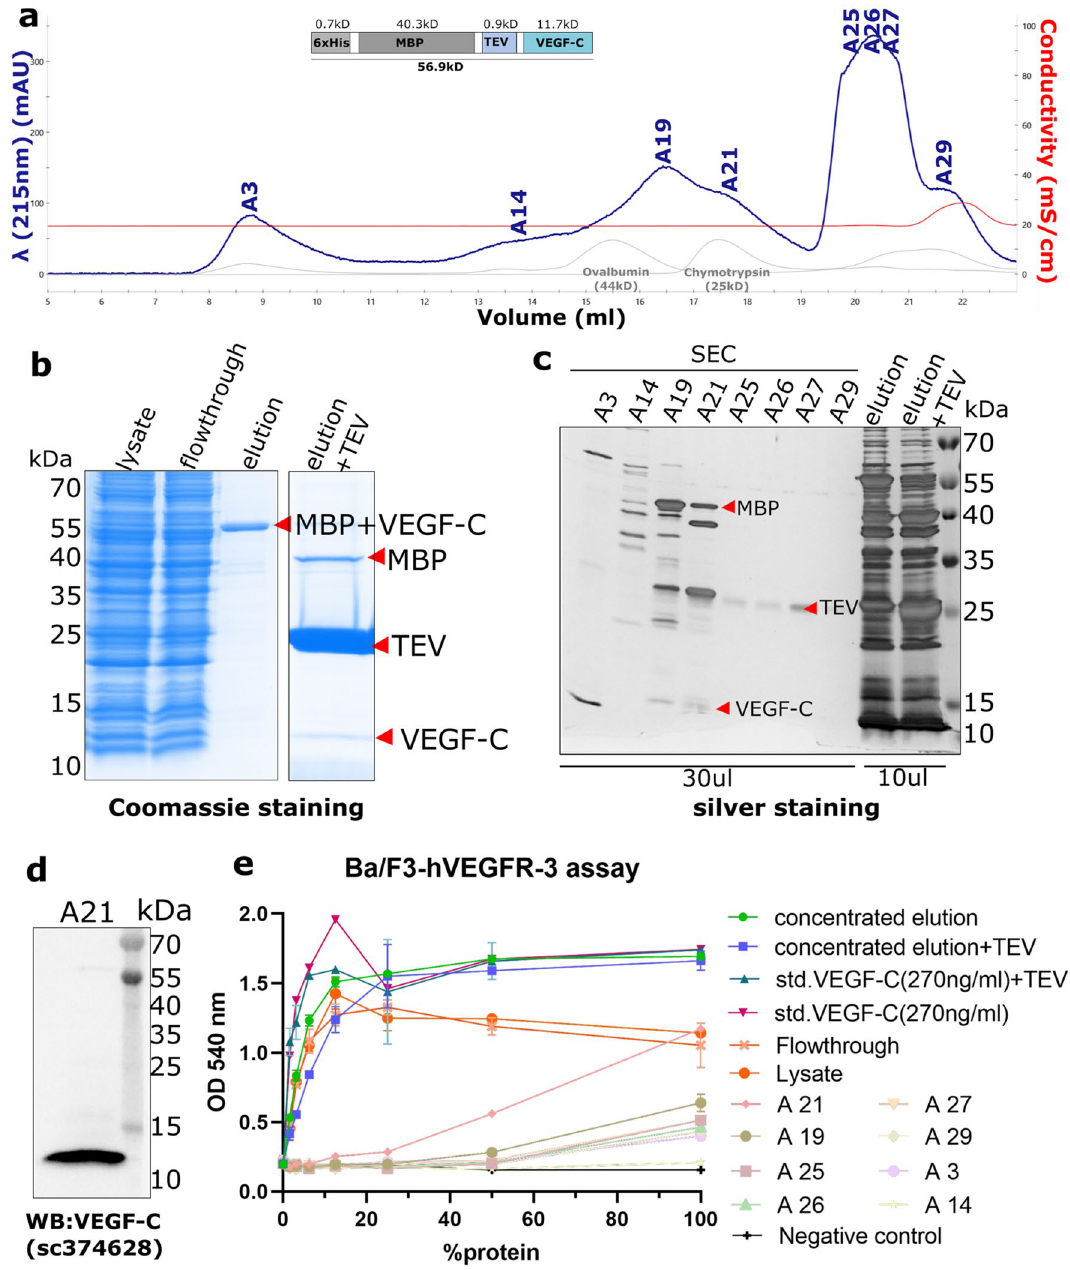
Figure 7. Purification of MBP-tagged VEGF-C using Amylose affinity chromatography. ( a ) Size-exclusion chromatogram of the MBP-VEGF-C fusion protein. ( b ) The fusion protein could be purified using Amylose affinity chromatography and the MBP tag could be cleaved using TEV protease. The peak fractions from SEC were resolved in SDS-PAGE followed by ( c ) silver staining and ( d ) western blotting. The bands corresponding to MBP + VEGF-C, MBP, TEV, and VEGF-C are indicated by red arrows. ( e ) Ba/F3-VEGFR-3/EpoR assay showing the activity of elution (with/without TEV cleavage), purified fractions, lysate, and flowthrough. Similar activity in lysate and flowthrough indicates that the majority of the active VEGF-C remained in the flowthrough. The line graph was generated using GraphPad Prism version 8.2.4 for Windows, GraphPad Software, San Diego, California USA, www. graph pad. com (n = 2) Error bars indicate ±